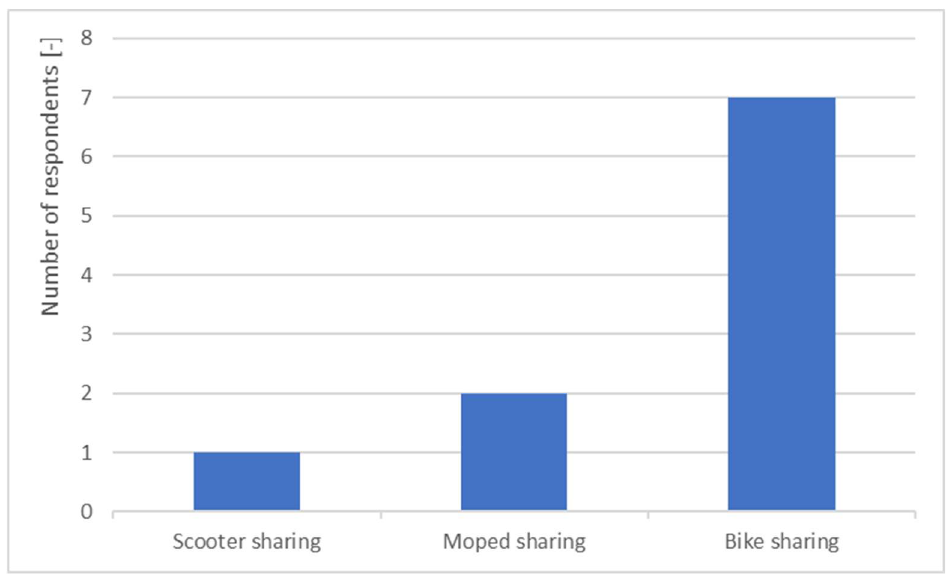
Figure 5. Companies with open innovation in the shared mobility market.